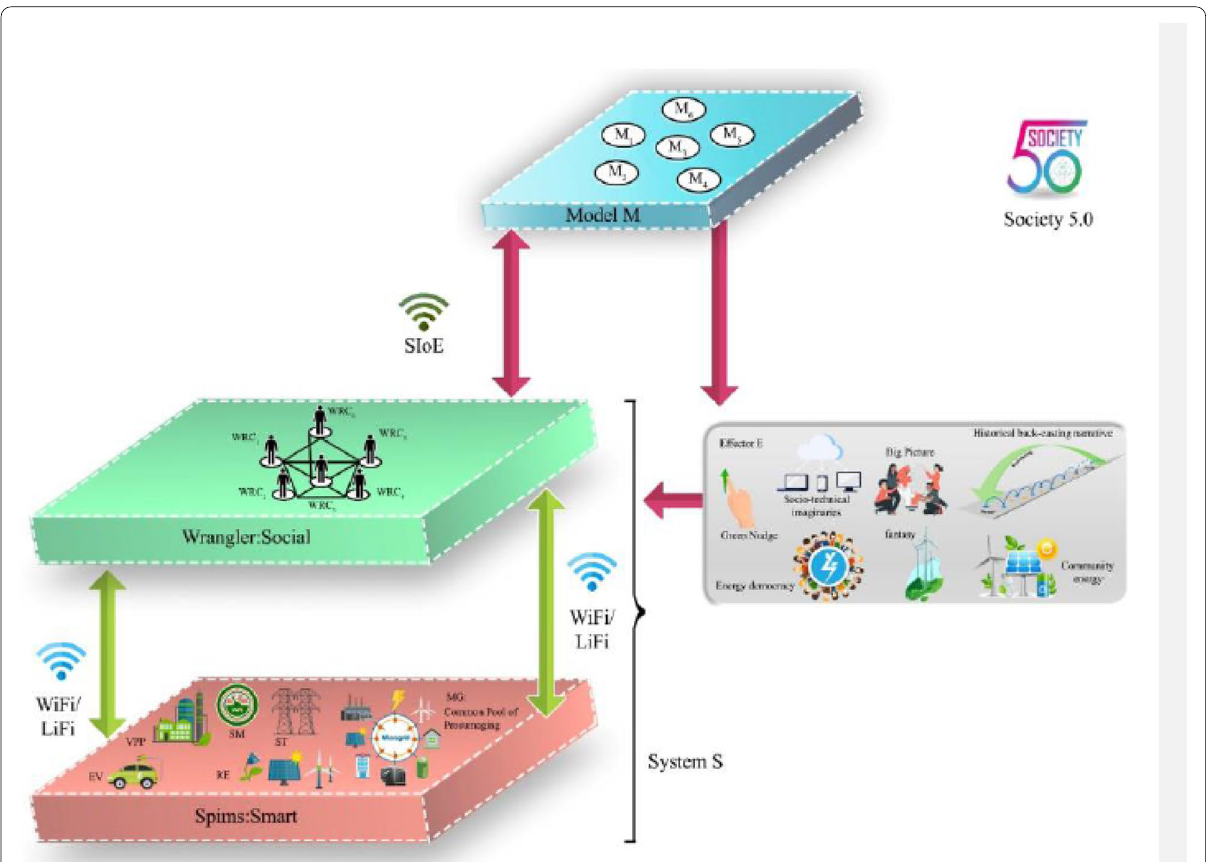
Fig. 6 Visual Sample of ASES: two-way arrows designate information